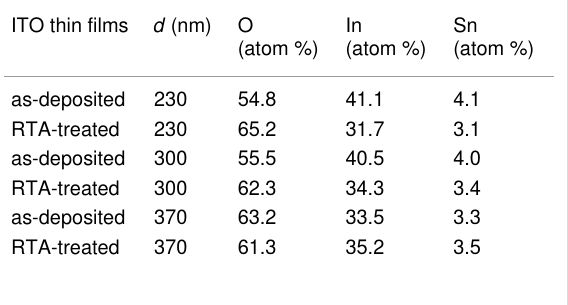
Table 3: Typical chemical composition of ITO thin films, determined by XPS